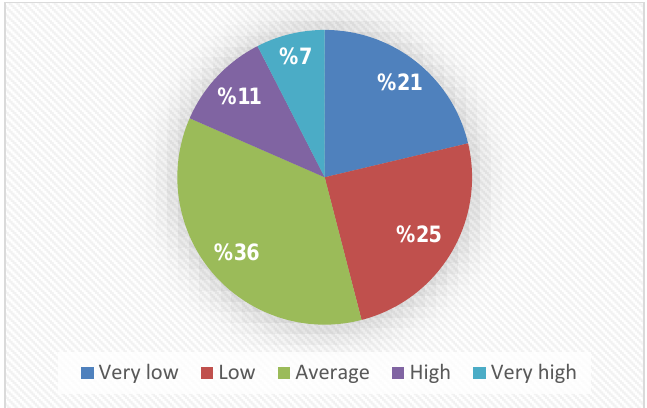
Fig. 4. The level of tourism’s satisfaction on trip to the